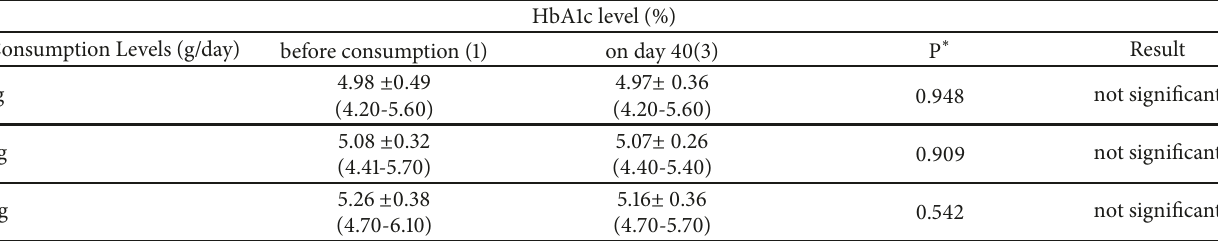
Table 5: The effect of cinnamon on the HbA1c